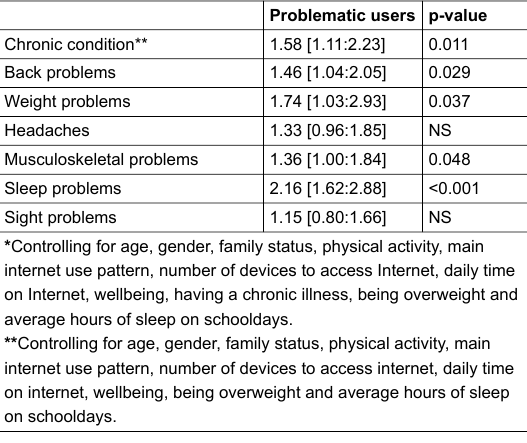
Table 2: Multivariate analysis for each health problem individually using average users as the reference group *.